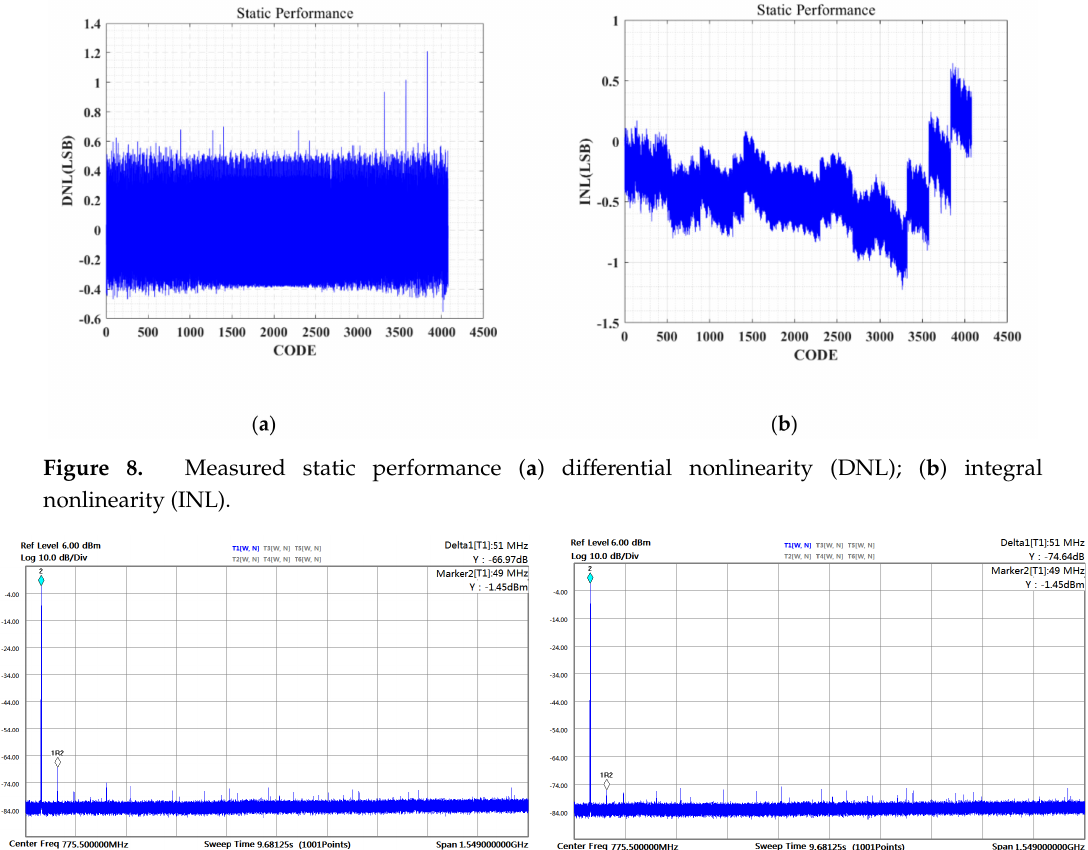
Figure 9. Measured spectrum at the 49 MHz output ( a ) with dynamic element matching (DEM) off; ( b ) with DEM on.